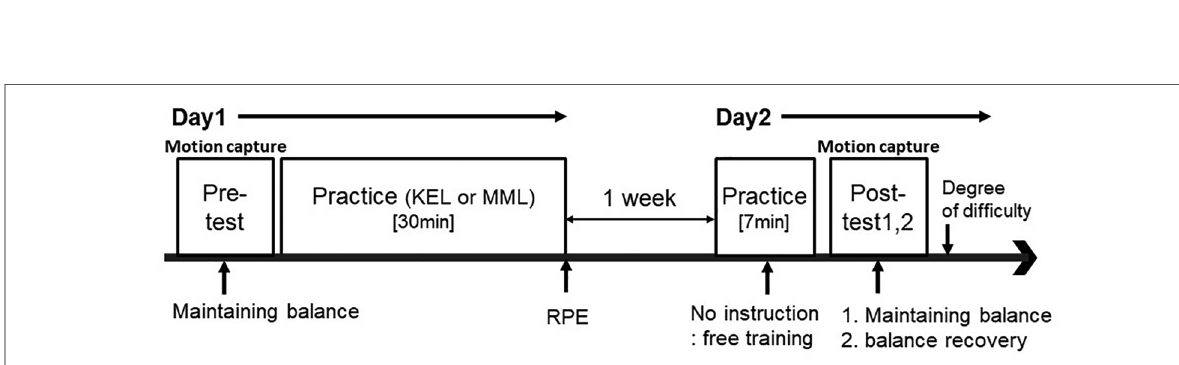
FIGURE 4 Test of balance recovery ability: left direction shifts task example. The width indicated by the yellow arrow is the movement width. Because the maximum movement width was de fi ned as the sum of all maximum values in the anteroposterior and mediolateral directions, all maximum values were converted to an absolute value. The fi ve trials were performed in each direction, totaling 20 trials.